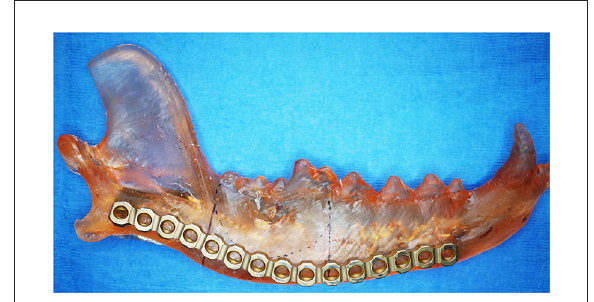
FIGURE4 3D printed mandible used to pre-contour a mandibular titanium reconstruction plate. Reprinted from Thatcher GP, Soukup JW. Virtual surgical planning and 3D printing in veterinary dentistry and oromaxillofacial surgery. Vet Clin North Am Small Anim Pract. 2022; 52(1): 221–234 with permission from Elsevier.